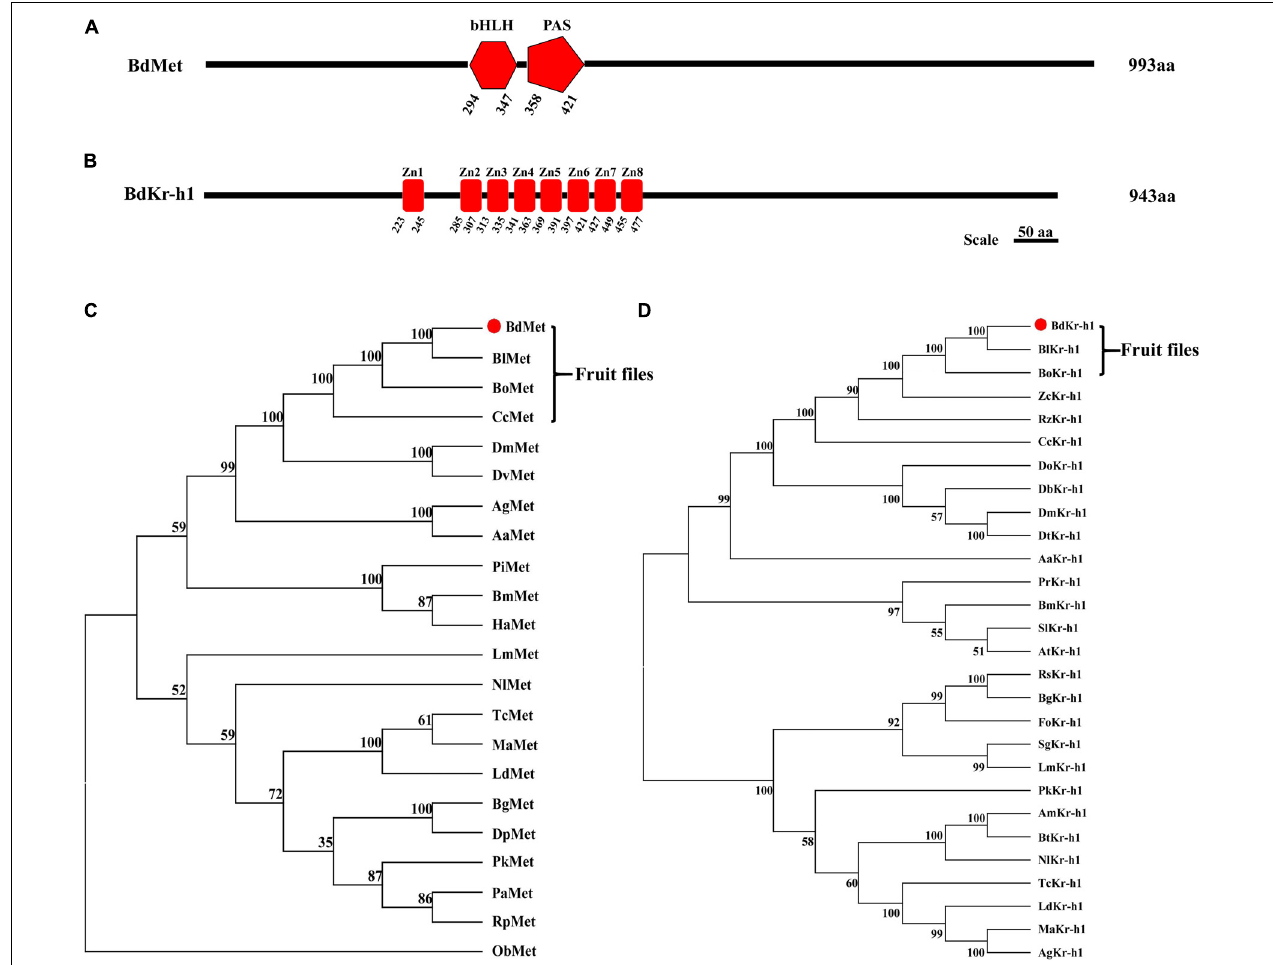
FIGURE 1 | Sequence analysis and a phylogenetic tree of Methoprene-tolerant (Met) and Kr-h1 in B. dorsalis and other insects. (A) Gene structure of B. dorsalis Met, black lines show the length and relative location of characteristic domains. BdMet protein contains bHLH and PAS domains. (B) Gene structure of B. dorsalis Kr-h1, black lines show the length and relative location of characteristic domain. BdKr-h1 protein contains eight putative zinc-finger domains. The amino acid sequences of BdMet (C) , BdKr-h1 (D) , and other insect Met and Kr-h1 sequences were selected to analyze the evolutionary relationship using the neighbor-joining method with the MEGA5.0. The numbers at the nodes of the branches represent the level of bootstrap support for each branch. The red dot stands for protein sequence of Met and Kr-h1 from B. dorsalis. The Met sequences followed by their GenBank Accession Numbers were listed in the order illustrated: BdMet in B. dorsalis (XP_011206298.1); BlMet in Bactrocera latifrons (XP_018782574.1); BoMet in Bactrocera oleae (XP_014085985.1); CcMet in Ceratitis capitata (XP_004527133.1); DmMet in Drosophila melanogaster (NP_511126.2); DvMet in Drosophila virilis (XP_002055682.1); AgMet in A. gambiae (ABC18327.1); AaMet in A. aegypti (AAX55681.1); TcMet in T. castaneum (NP_001092812.1); MaMet in Monochamus alternatus (ANW09588.1); BmMet in B. mori (NP_001108458.1); HaMet in Helicoverpa armigera (XP_021188262.1); PiMet in Plodia interpunctella (ANZ54967.1); LmMet in L. migratoria (AHA44478.1); NlMet in Nilaparvata